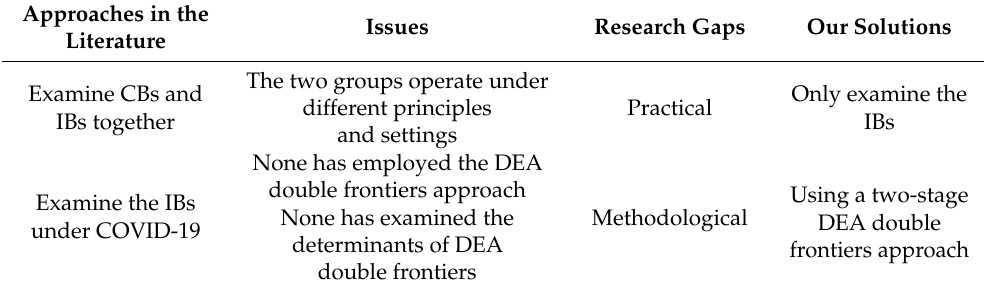
Table 1. The characteristics of our